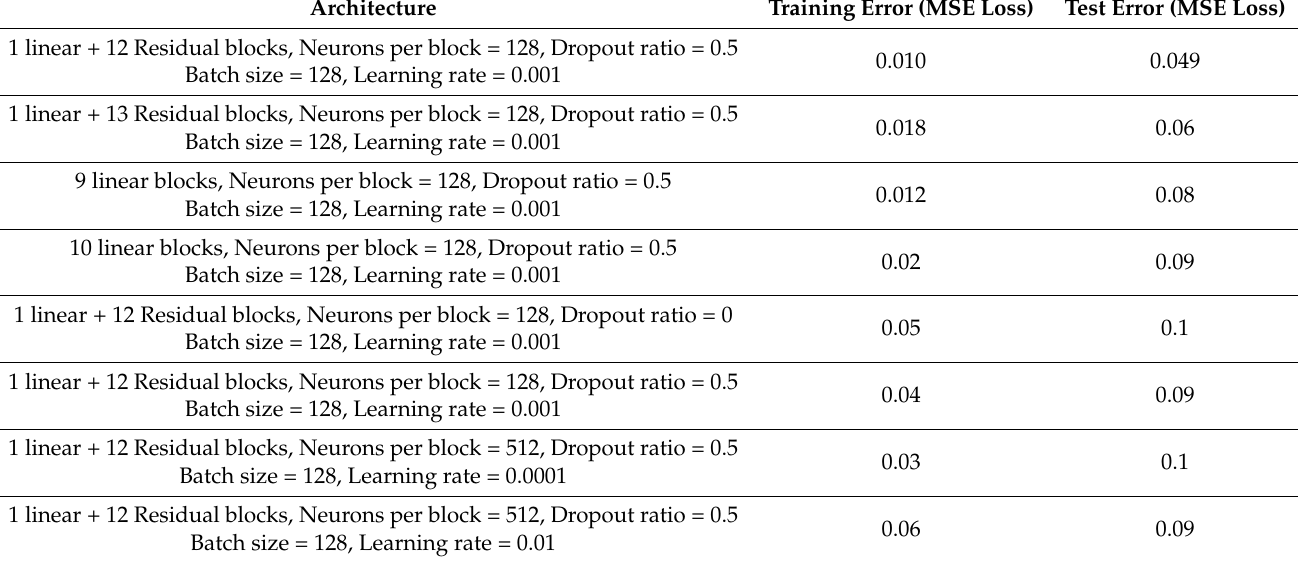
Table 2. Model architecture experiment—a sample of higher accuracy architectures and associated prediction errors for training and test datasets.